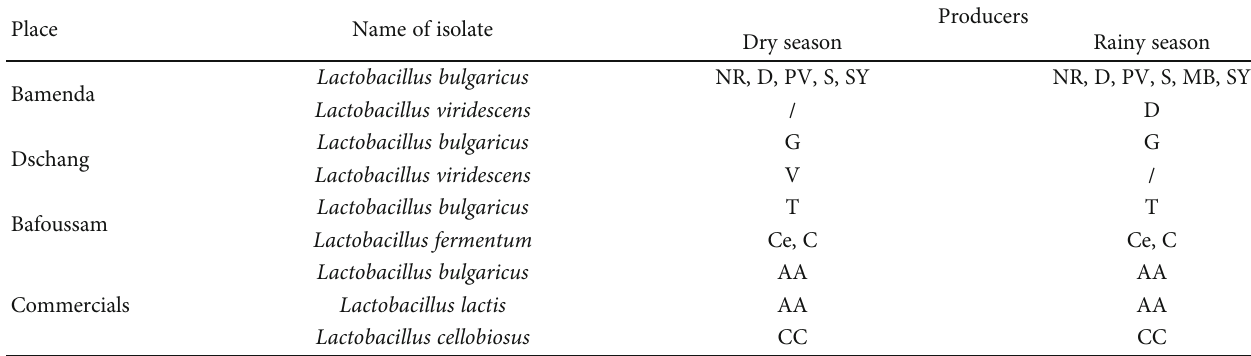
Table 2: Lactobacillus species found in yoghurt samples during the dry and rainy